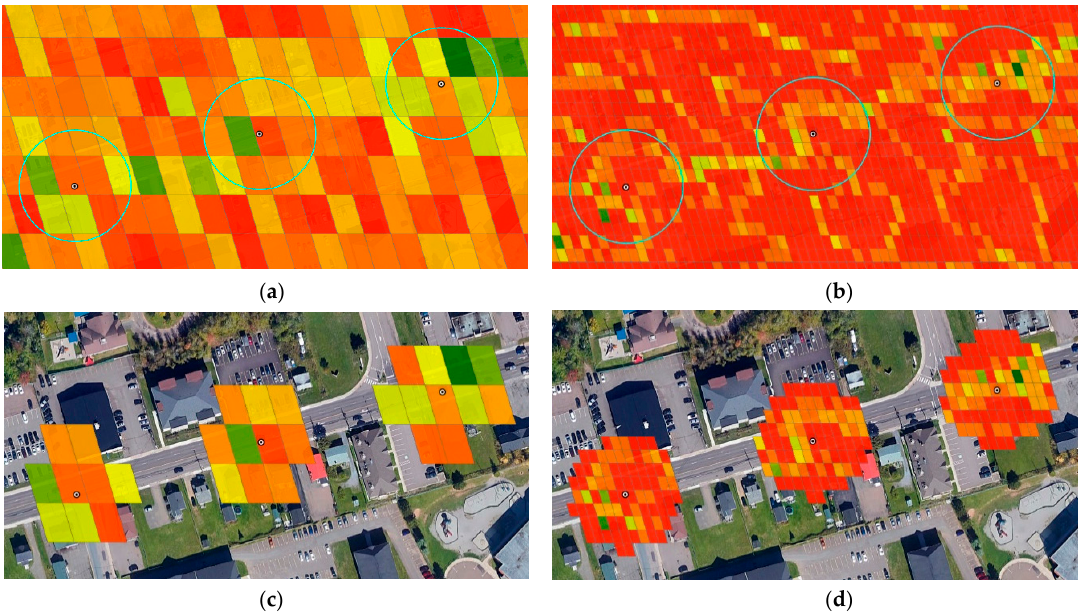
Figure 10. ( a , b ) A series of points representing locations of a mobile IoT device surrounded by a 30 m offset region and cells colored to simulate aggregate values at resolution 12 and 13 respectively. ( c ), ( d ) Visualizing offset region cells from ( a ) and ( b ) respectively around each point (©2020 Google Earth).